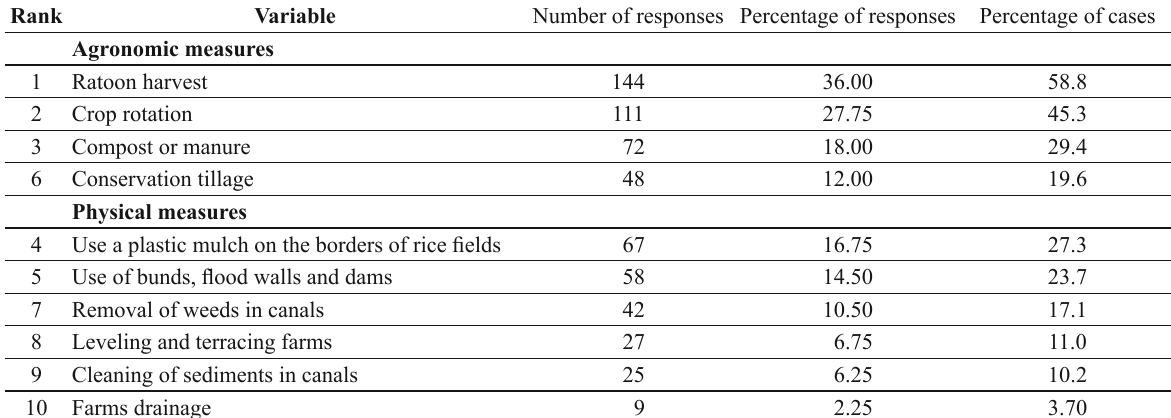
Frequency and ranking of use of soil and water conservation practices by paddy